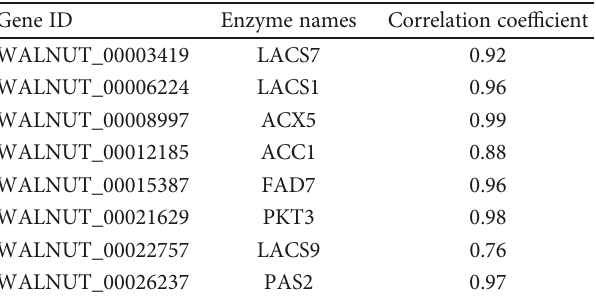
Figure 6: Expression analysis of fatty acid synthesis candidate genes in walnut kernels at di ff erent developmental stages. Table 7: Correlation coe ffi cients of candidate genes related to the walnut lipid synthesis between expression and transcriptome